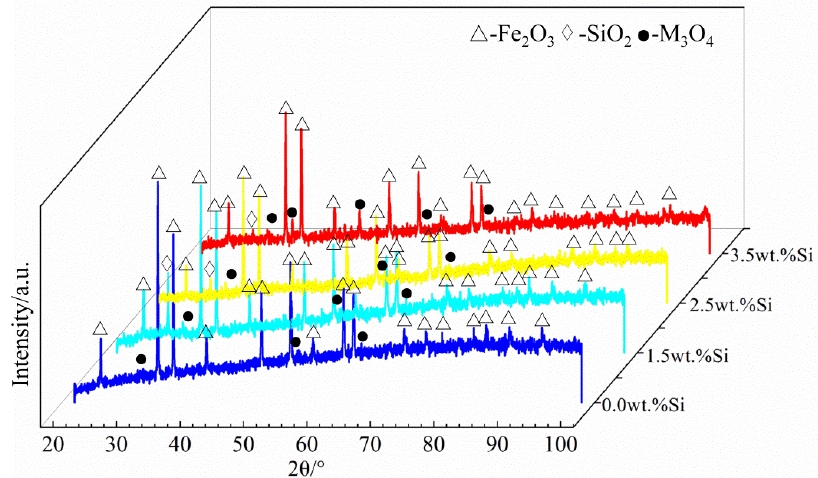
Figure 8. XRD on the surface of Fe 2 B // sample oxide film after oxidation for 100 h.